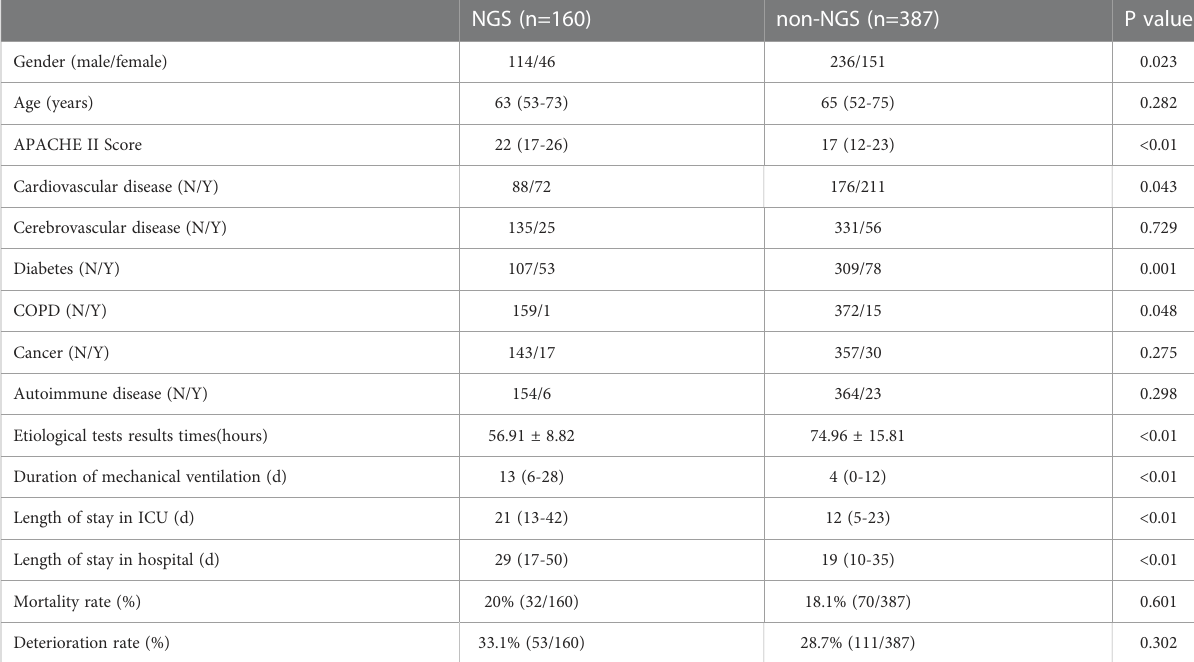
TABLE 1 Baseline characteristics and clinical indices of NGS and non-NGS groups.